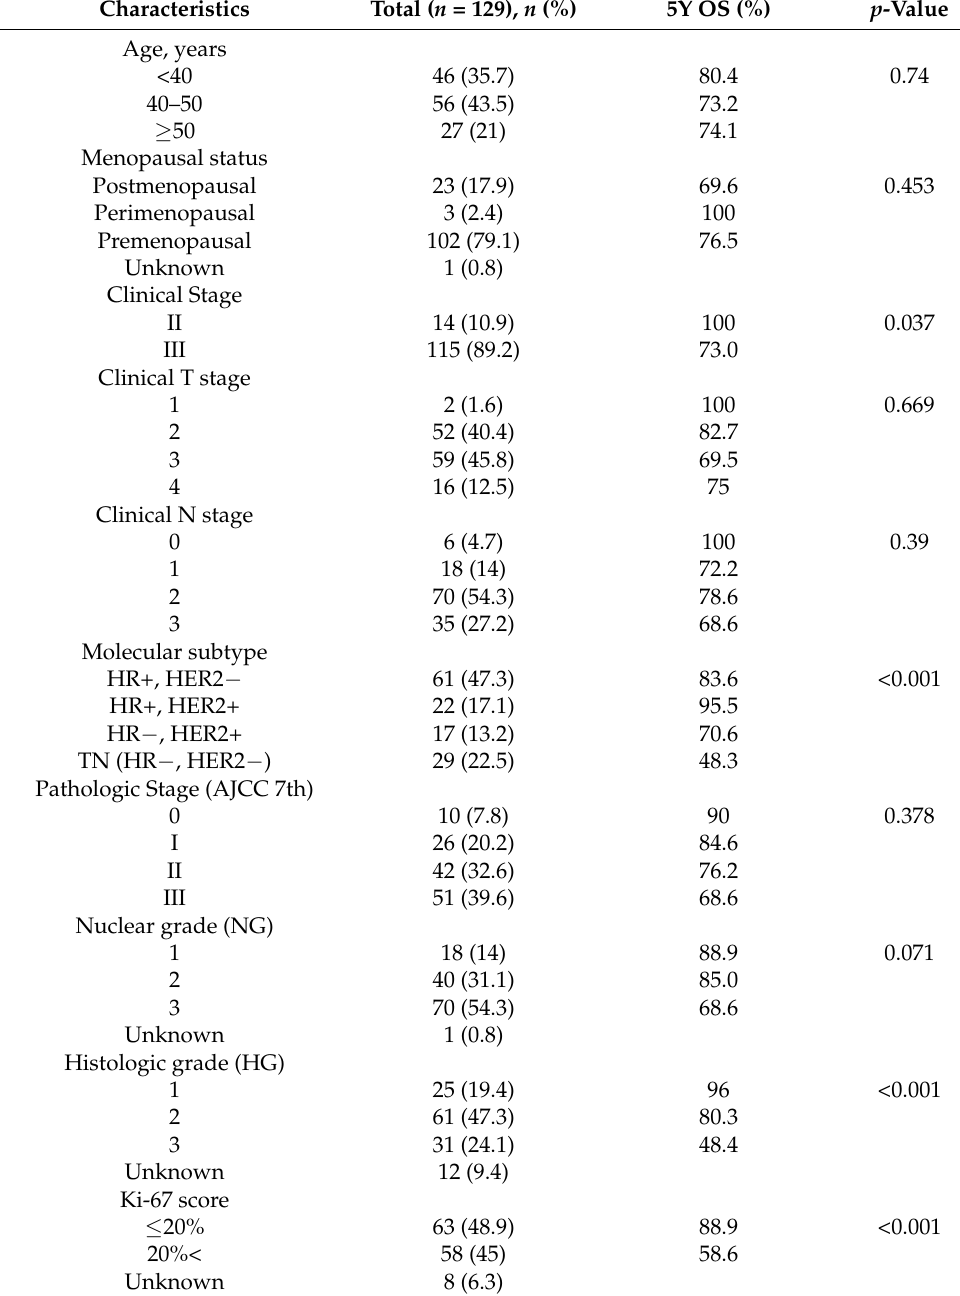
Table 1. Patient characteristics and clinical outcomes.